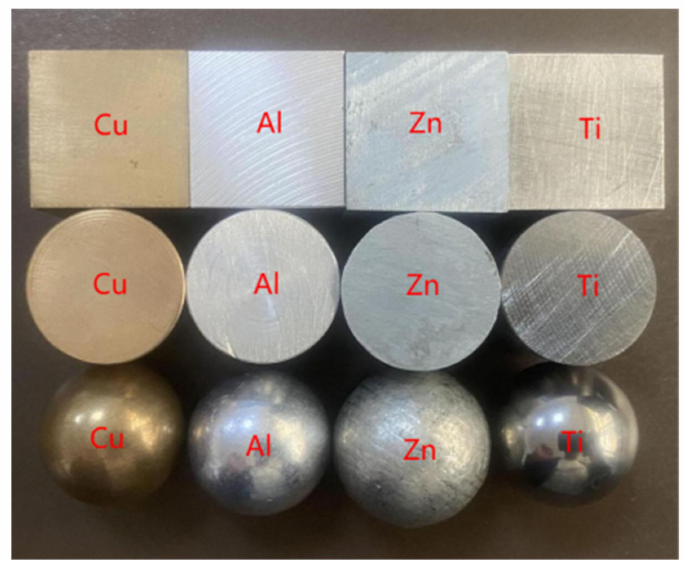
Figure 5. Metal samples.